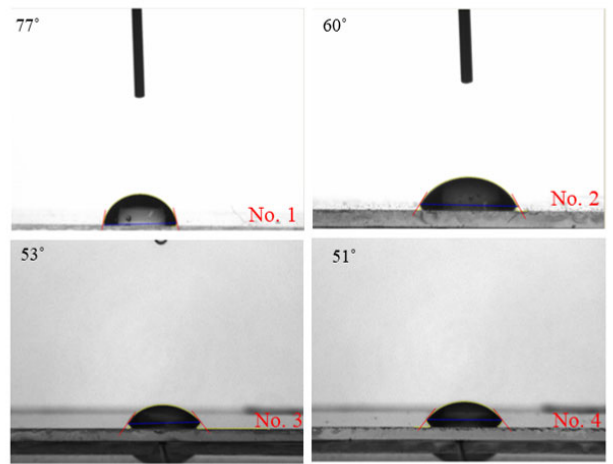
Figure 1. Contact angles of the prepared catalytic electrode by plasma deposition (see Table 1).